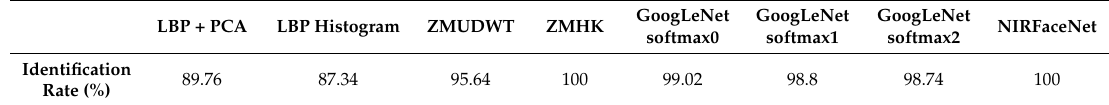
Table 3. Identification rates of various methods tested on Test Set 1.